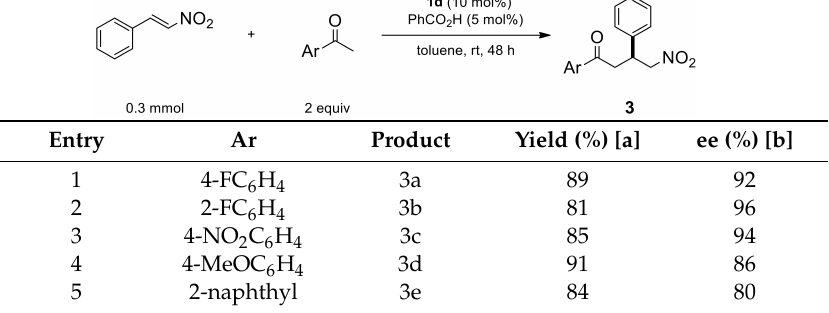
Table 6. Reaction conditions according to the type of aromatic